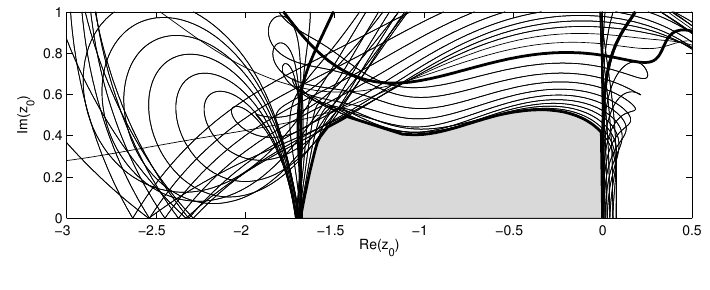
Figure 9. Stability regions S π/ 2 ,y , y = − 2 . 0 , 1 . 8 ,..., 2 . 0 (thin lines), S π/ 2 (shaded region), and S E (thick line) for β 32 = − 0 . 103241056324758, β 42 = − 1 . 642317211614867, β 43 = 0 . 371951766360894, β 52 = − 2 . 912021006631820, β 53 = 3 . 197905476549485, and β 54 = 0 .